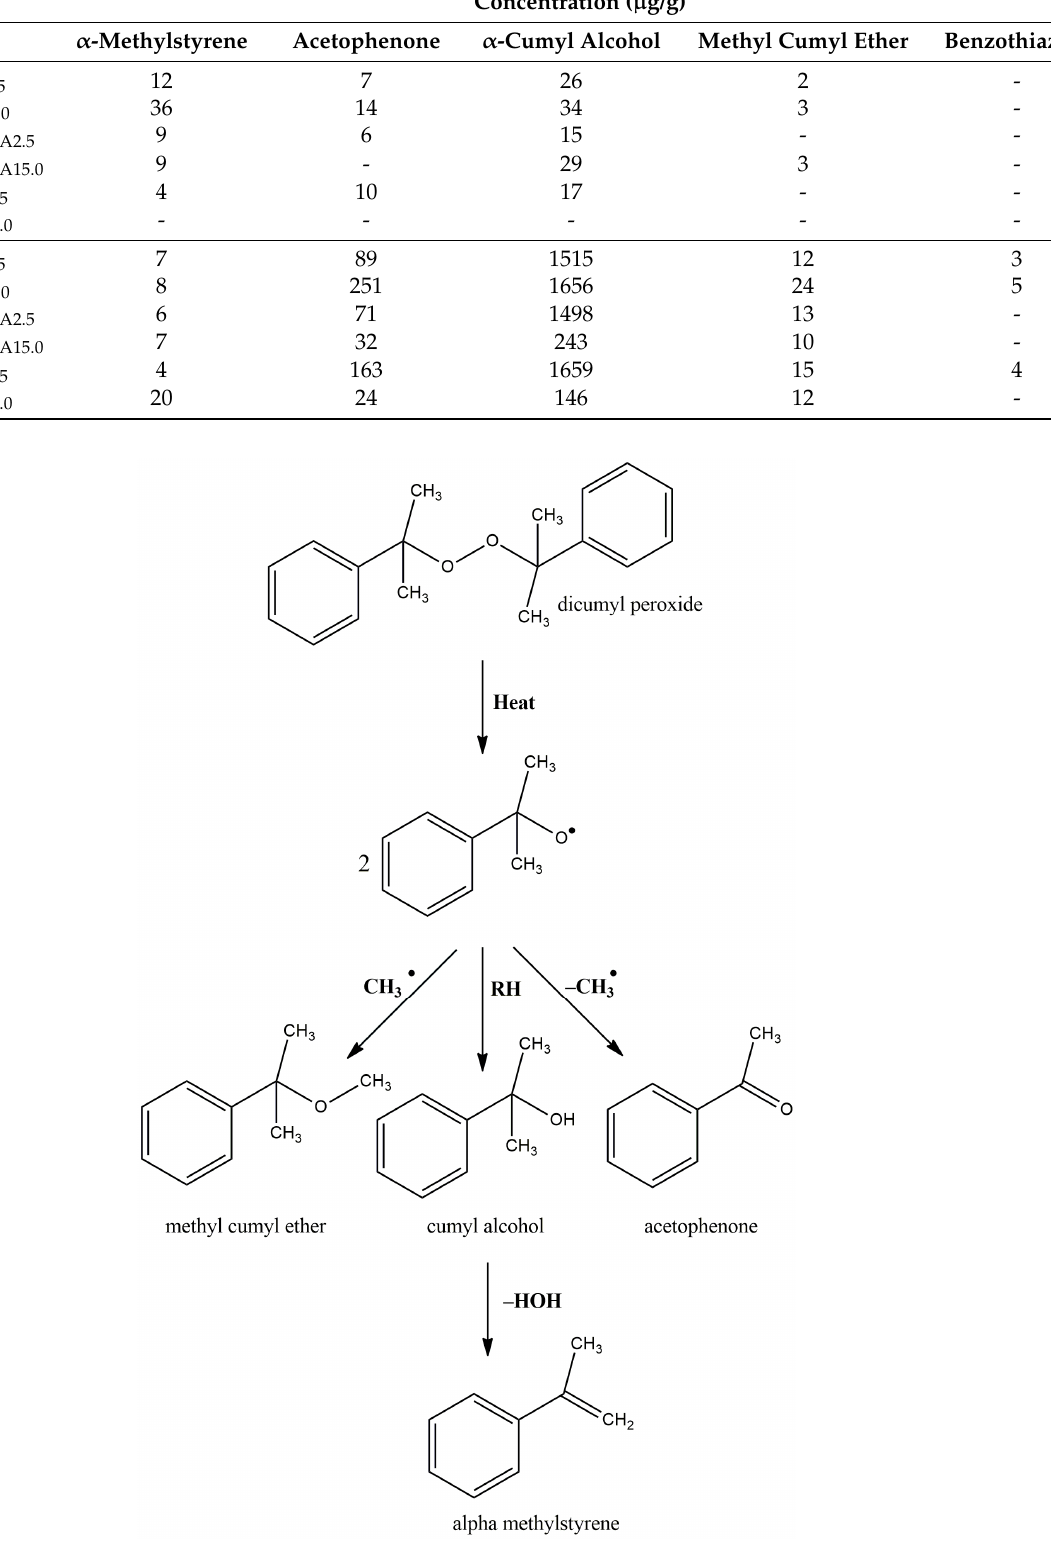
Figure 6. Mechanism of dicumyl peroxide decomposition.